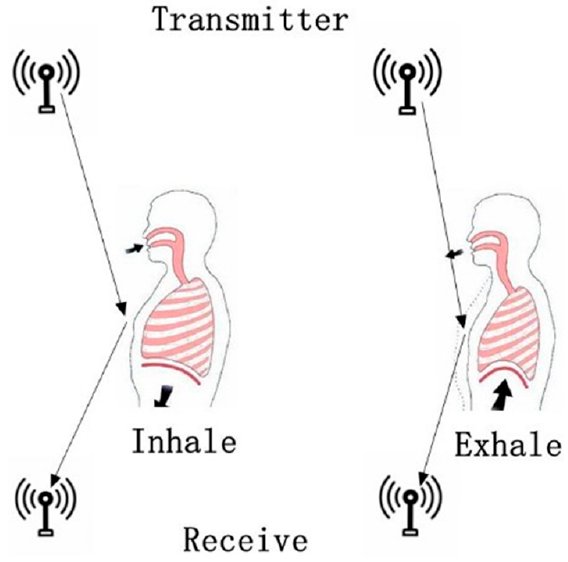
Figure 1. Schematic diagram of human respiration.